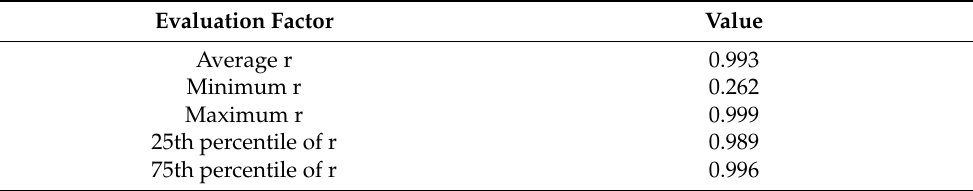
Table 1. Performance summary of U-net model on test dataset for ABP waveform